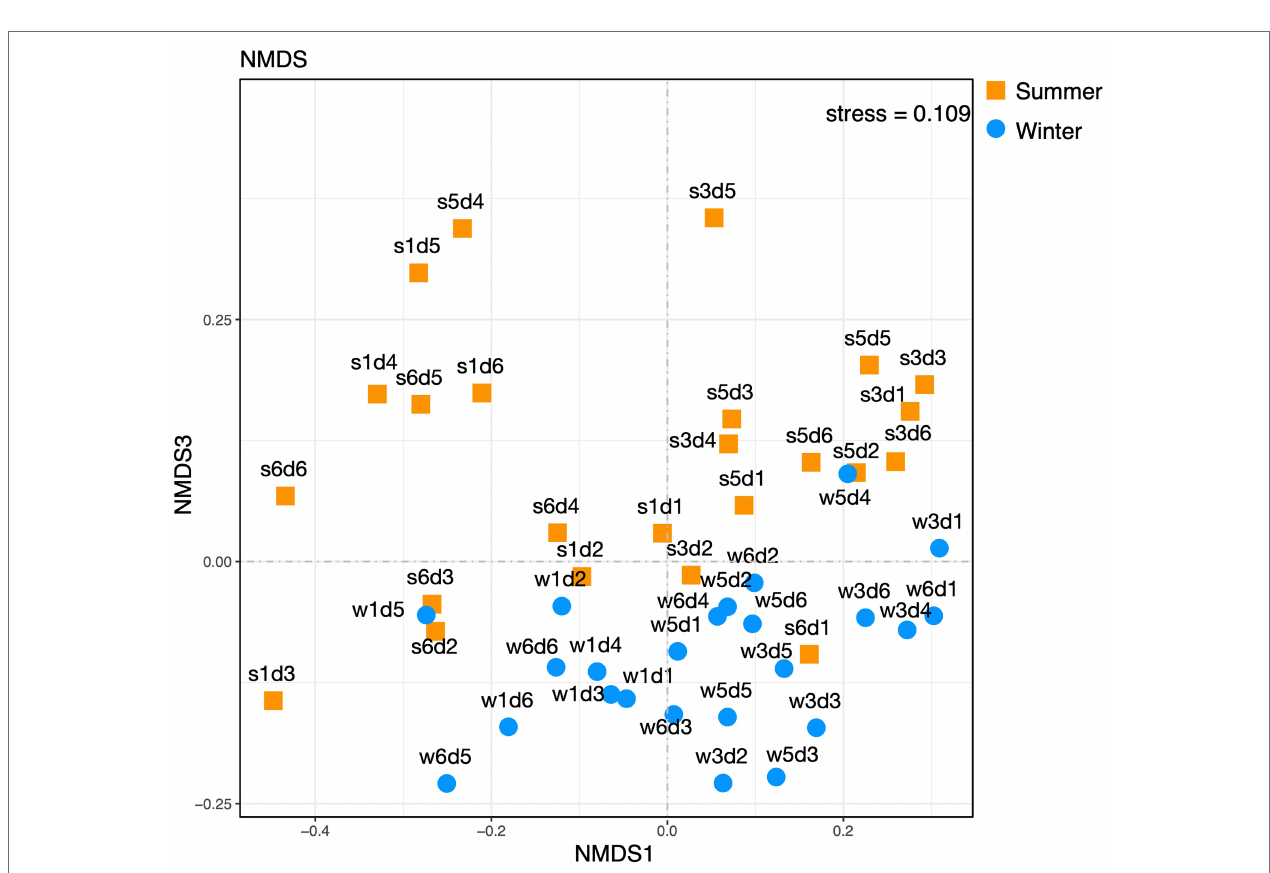
FIGURE 5 | Non-metric multidimensional scaling plot of 3% OTU compositions from the summer and winter